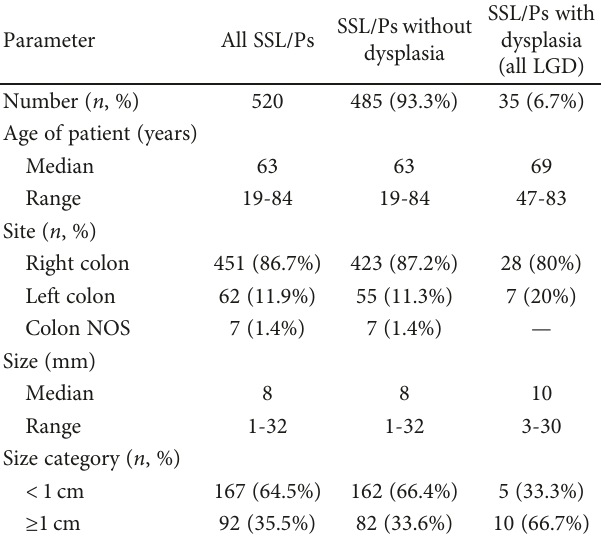
Table 3: Characteristics of SSL/Ps identi fi ed over a 12-year period at our institution; n = 520